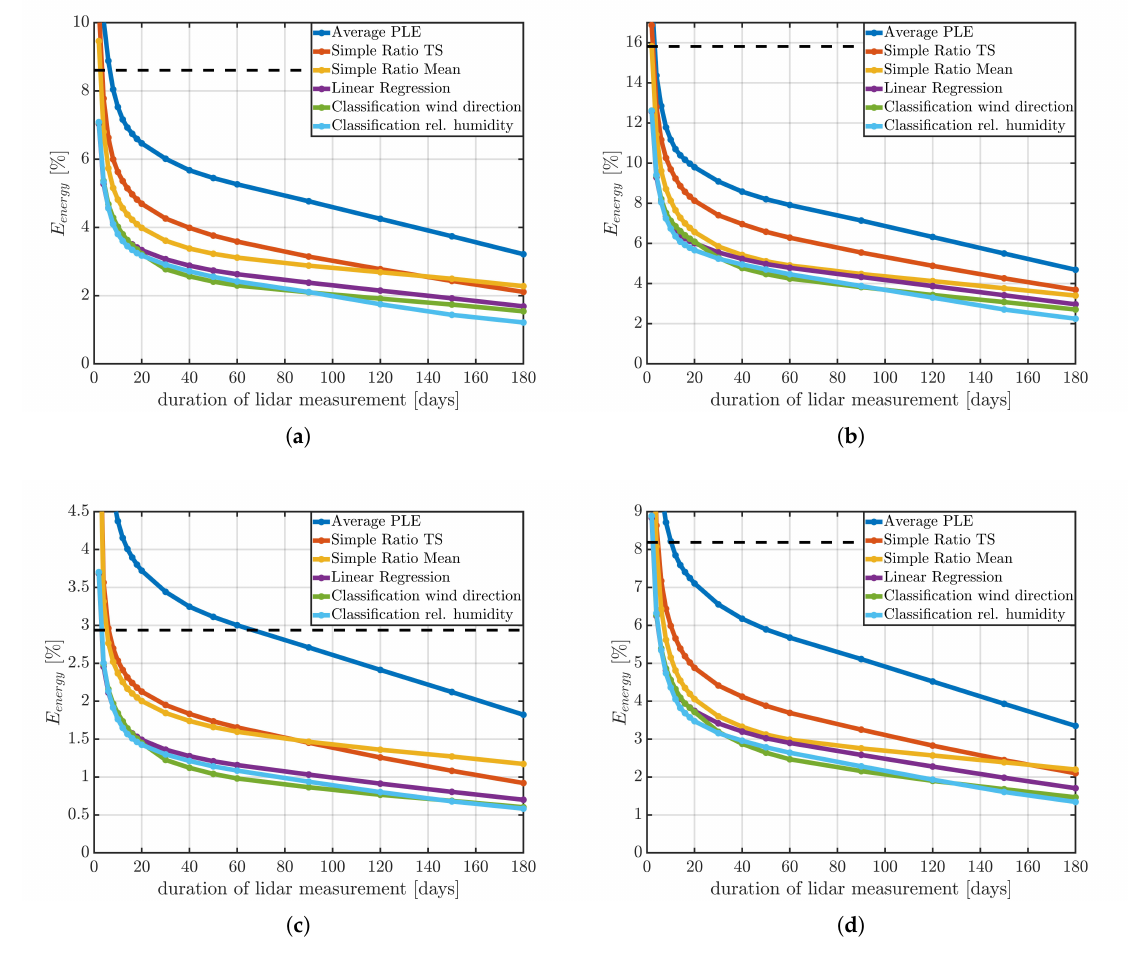
Figure 8. The average extrapolation error E energy in dependence of the duration of the lidar measurement (RMSE over all sites and starting times), for ( a ) z 2 = 80 m and z t = 140 m; ( b ) z 2 = 80 m and z t = 200 m; ( c ) z 2 = 100 m and z t = 140 m; ( d ) z 2 = 100 m and z t = 200 m. The black dashed lines represent the errors of the scenario of extrapolating without lidar